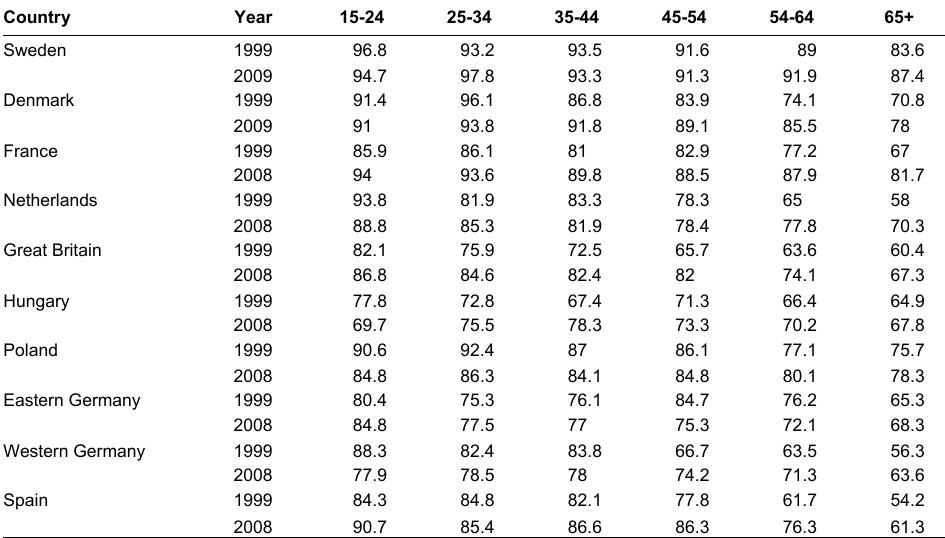
Table 1 : The percentage who agree to the nurturing father, differentiated by country age and year (weights